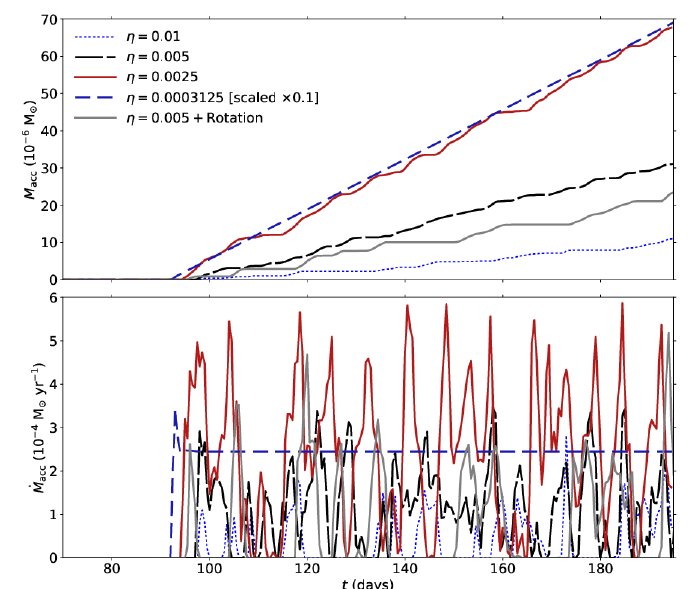
Figure 3. ( a ) The total accreted mass. ( b ) The mass accretion rate. Note the different scaling for Run 6 ( η = 0.0003125). The average accretion rate is given in Table 1 and Figure